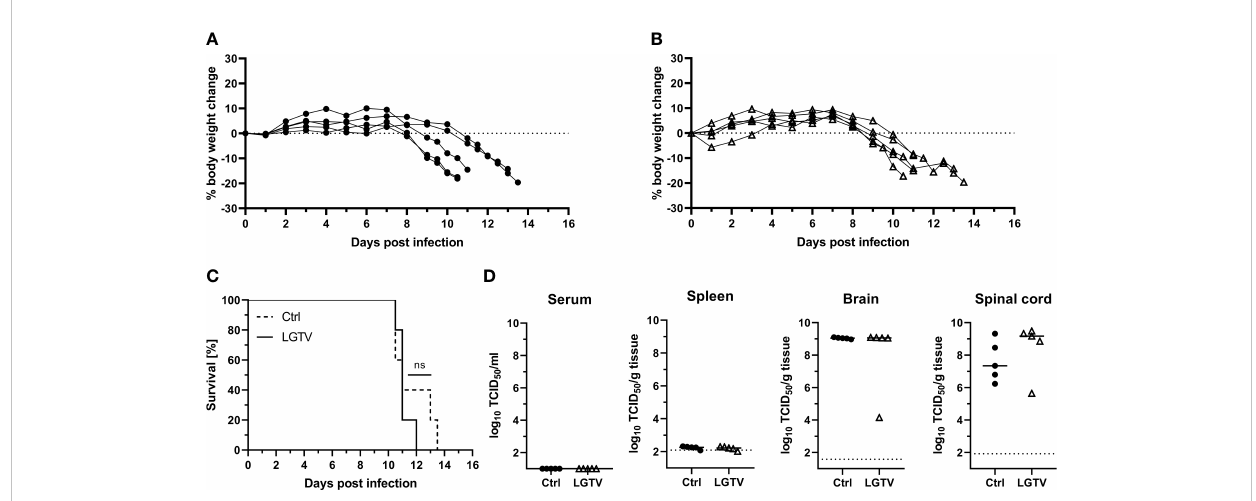
FIGURE 5 T cells from LGTV infected mice do not protect mice against subsequent TBEV challenge infection. CD3 + T cells puri fi ed from control or LGTV infected mice (n=5) were i.p. administered into naïve recipient mice (n=5). Following TBEV challenge infection, body weight of mice that received T cells of (A) control or (B) LGTV infected mice was monitored over a period of 16 dpi. Mice were taken out when they reached the HEP. (C) Survival curve plotted for the recipient mice that received control CD3 + T cells (dotted line) or CD3 + T cells from LGTV infected mice (solid line). Signi fi cant difference was analyzed by log rank test (p = 0.4389). (D) TCID50 was performed on serum and tissue homogenates to determine the viral load in serum, spleen, brain and spinal cord of control ( (cid:129) ) or LGTV ( D ) CD3 + T cell recipients collected at the day of sacri fi ce. Median values are